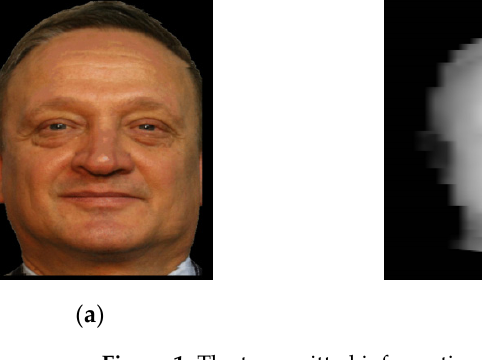
Figure 1. The transmitted information on a 3D object: ( a ) texture, ( b ) mask, ( c ) 3D assembly. The direct SSB transmission was performed along the Wi-Fi channel in the packages containing 500 pairs of images, as in those shown in Figure 1a,b, with the measurement of transmission rate [17].